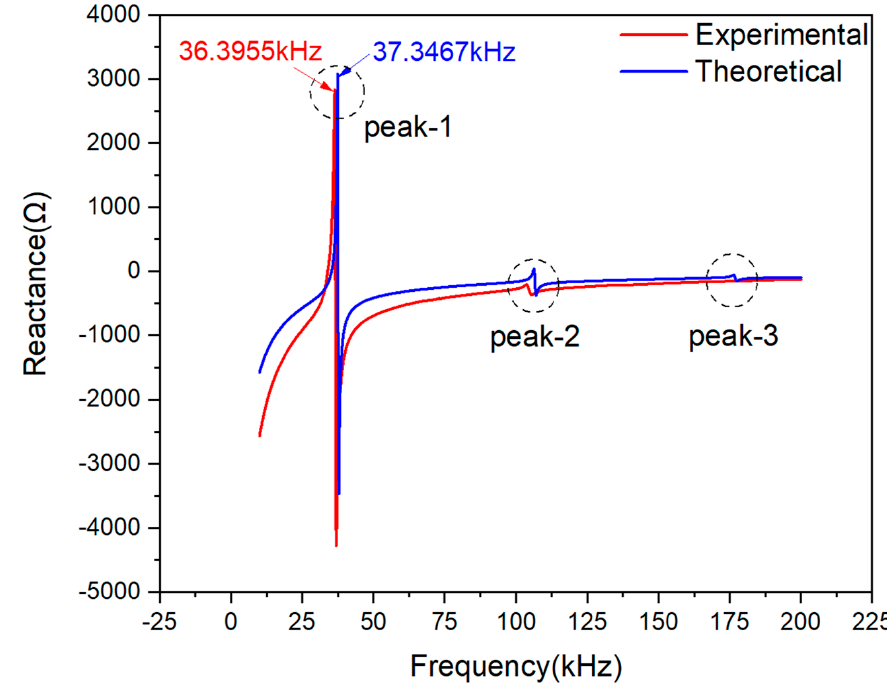
Figure 8. Experimental and theoretical reactance plots comparison of PZT#1.